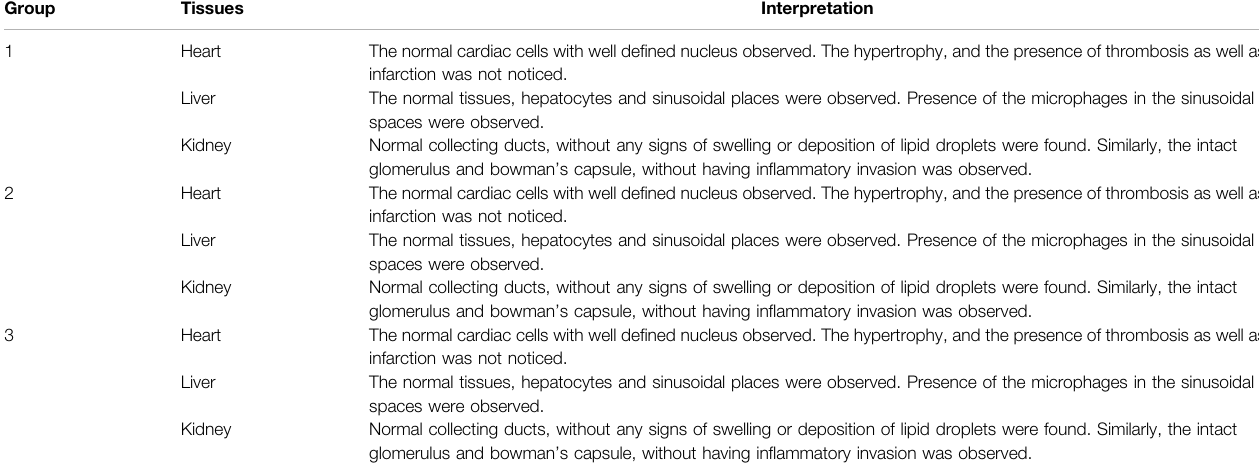
TABLE 5 | Histopathological evaluation of vital organs including heart, liver, and kidney of the animal. Group Tissues Interpretation